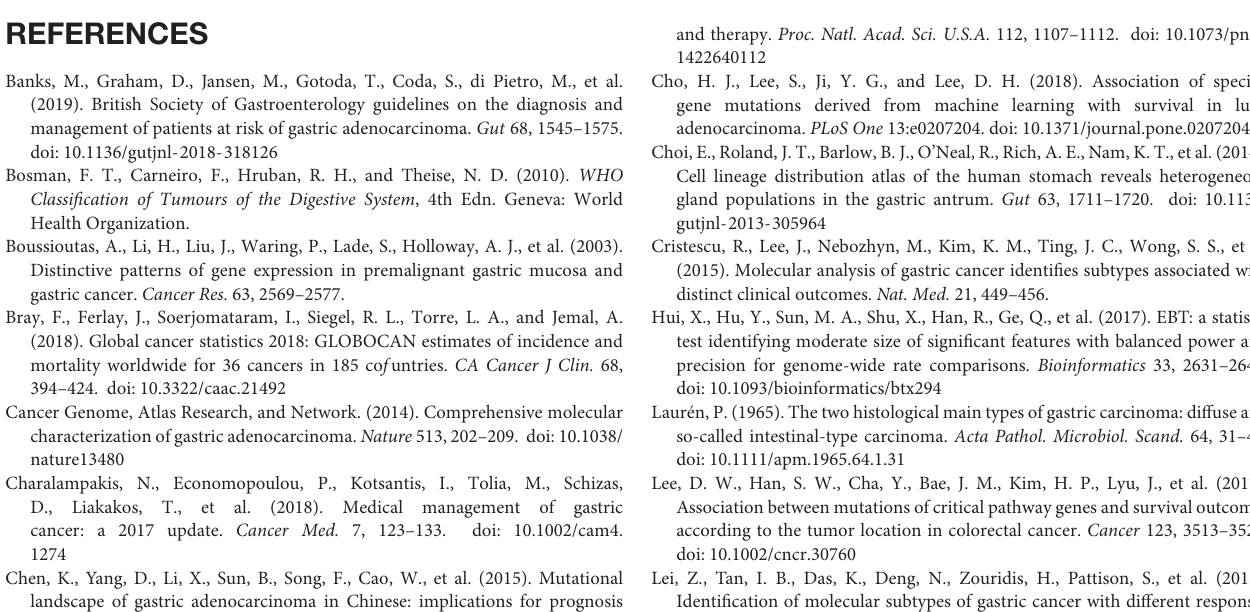
FIGURE S1 | The general prognosis of TCGA STAD cases and the functional enrichment analysis of the prognosis-associated genes. (A) The good and poor prognostic groups of STAD cases within different survival periods, including 1, 2, and 3 years and the median of 573 days. (B) Gene Ontology (GO) enrichment analysis of the top 52 genes with significant mutation rate difference between the prognostic groups stratified by the median survival time. FIGURE S2 | TML distribution for different prognostic groups of the TCGA cases. The distribution of TMLs (A) and missense TMLs (B,C) for TCGA cases of good and poor prognosis groups for the raw TCGA training dataset stratified by 573-day survival or classified by the f52 model. The p -value of Wilcoxon rank-sum test was indicated. FIGURE S3 | Distribution analysis on clinical factors of the training cases. Sex (A) , anatomic regions of stomach (B) , clinical TNM stage (C) , and the two main histological types of gastric carcinoma (D) were involved. Chi-square tests were performed and the p -values were indicated. FIGURE S4 | Performance comparison of the prognosis prediction models based on 52 somatic mutation features and clinical TNM stage information. Specificity (Sp), Sensitivity (Sn), Accuracy (ACC), and Mathews Correlation Coefficient (MCC) were utilized to assess the predictive performance. The model f52 was based on the 5-fold cross-validation results. Pairwise one-tail Student’s t -tests were performed, and the p -values were indicated. FIGURE S5 | Performance comparison of the prognosis prediction models based on 52 somatic mutation features and MUC16. Specificity (Sp), Sensitivity (Sn), Accuracy (ACC), and Mathews Correlation Coefficient (MCC) were utilized to assess the predictive performance. The model f52 was based on the 5-fold cross-validation results. Pairwise one-tail Student’s t -tests were performed, and the p -values were